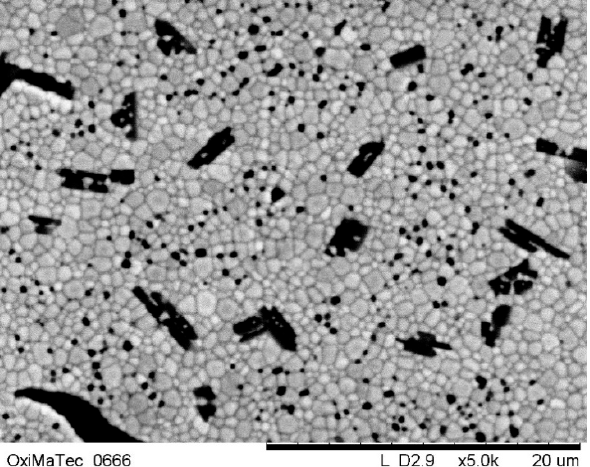
Figure 39. Microstructure of final Y-Ce-TZP/Al 2 O 3 /LaAl 11 O 18 (ZA05P).